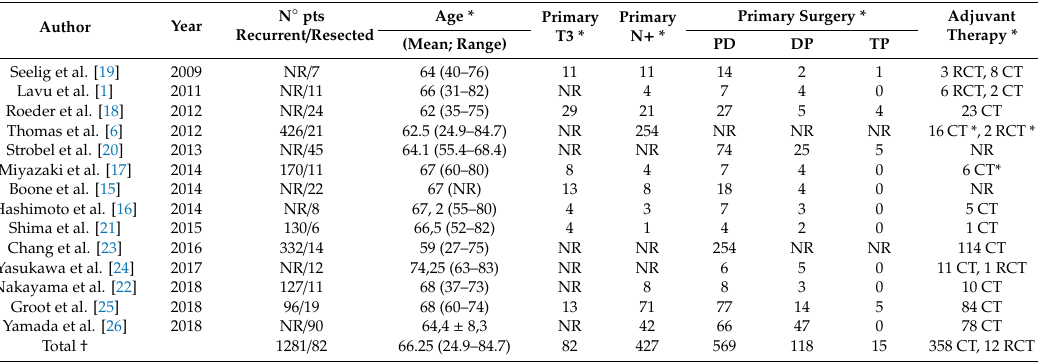
Table 1. Characteristics of the primary pancreatic cancer.